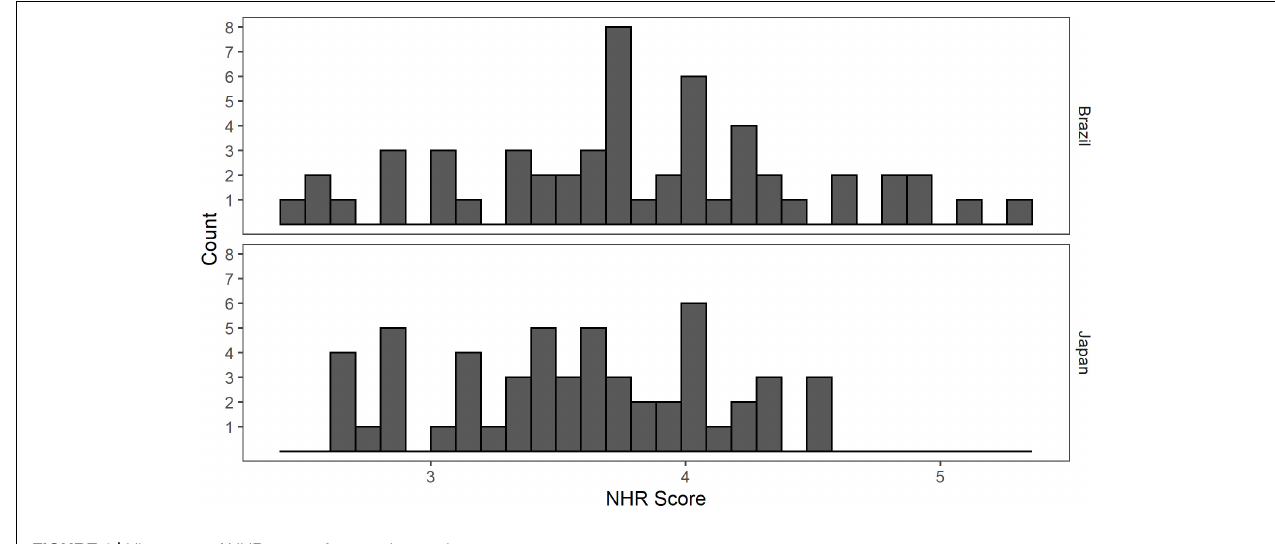
FIGURE 1 | Histogram of NHR scores from each sample.